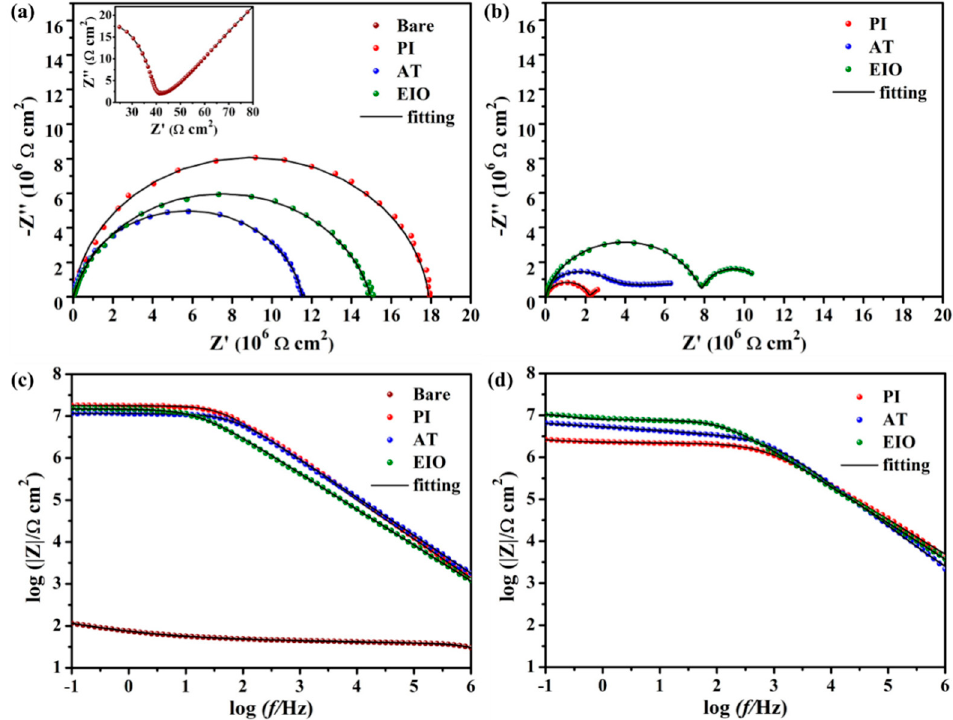
Figure 6. The PI, AT, and EIO coatings measured in 3.5 wt.% NaCl solution for Nyquist plots for ( a ) 1 day, ( b ) 30 days and Bode plots ( c ) 1 day and ( d ) 30 days. The inset shows the Nyquist plots for neat CRS.